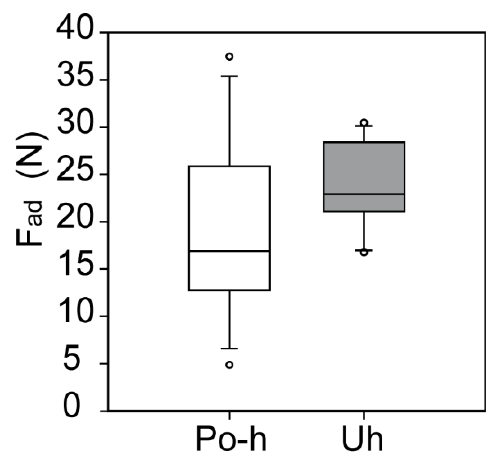
Figure 4. Adhesion force of P. ovata husk mucilage and UHU glue control sample. Abbreviations: Po-h— Plantago ovata husk mucilage, Uh—UHU glue. In the box-and-whisker diagram, the bottom and top of the box are the 25th and 75th percentiles, the line inside the box is the median; the ends of the whiskers are the 10th and 90th percentiles.